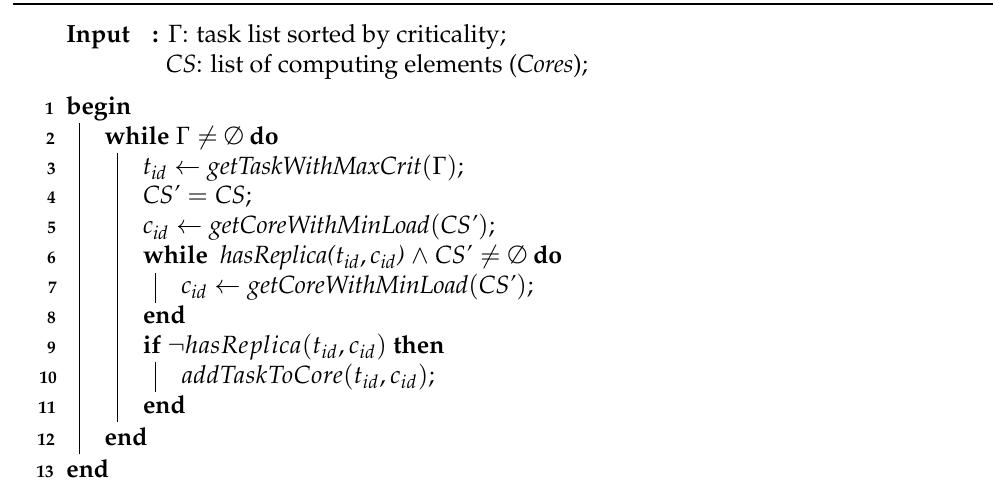
Algorithm 1: Criticality-arithmetic-aware allocation of tasks to